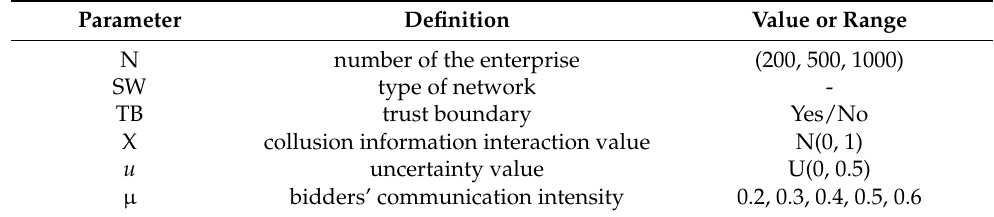
Table 1. Parameter setting in simulation